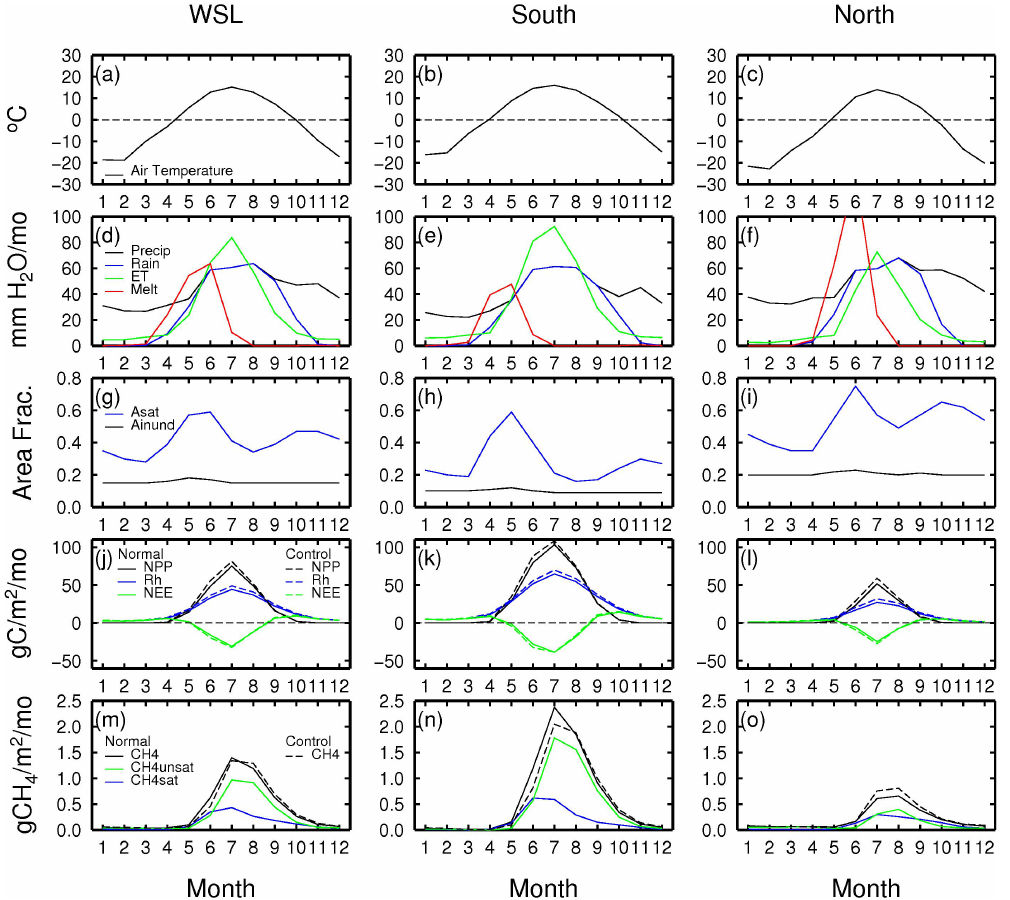
Fig. 8. 2001–2010 monthly average meteorological forcings and simulated states and fluxes, per unit wetland area.